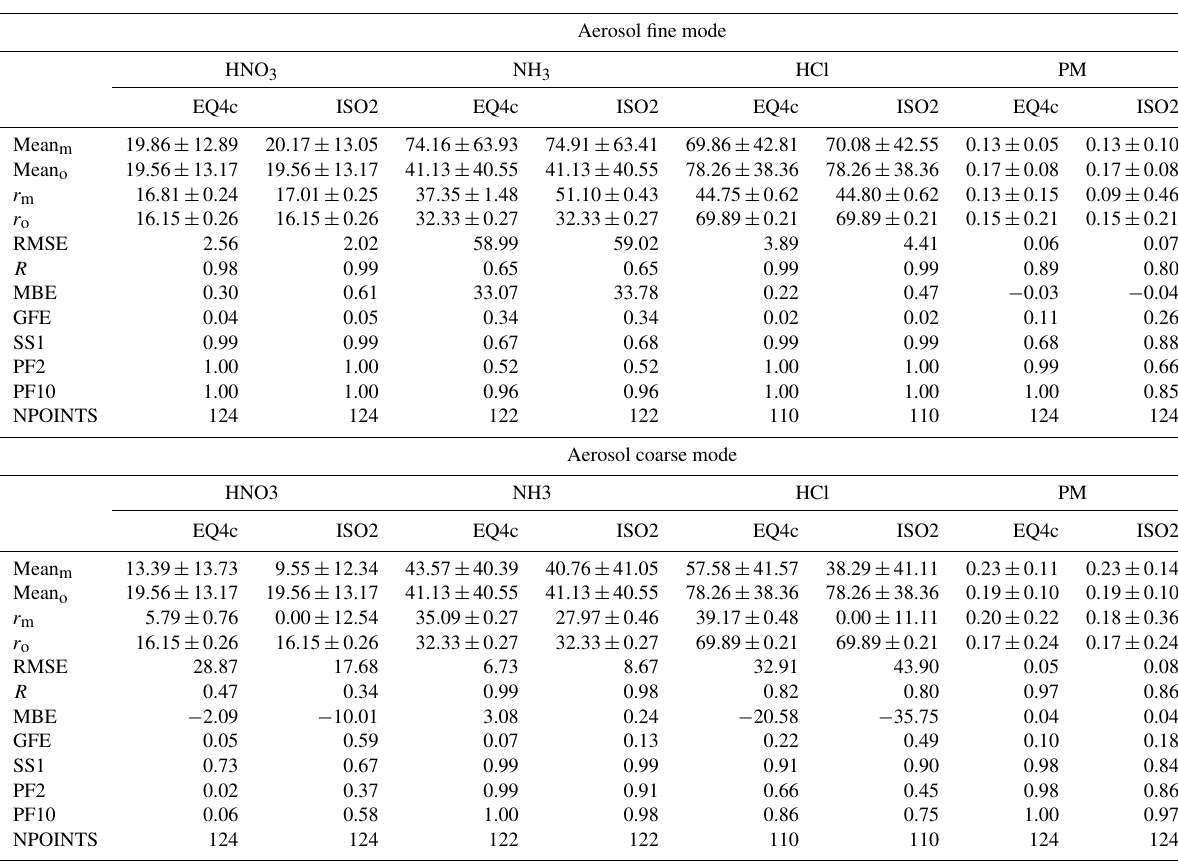
Table 5. MINOS aerosol statistics (see Figs. 8, 9 of Sect. 3.4; Appendix C for the evaluation metrics): EQSAM4clim (EQ4c) and ISORROPIA II (ISO2) versus MINOS observations (August